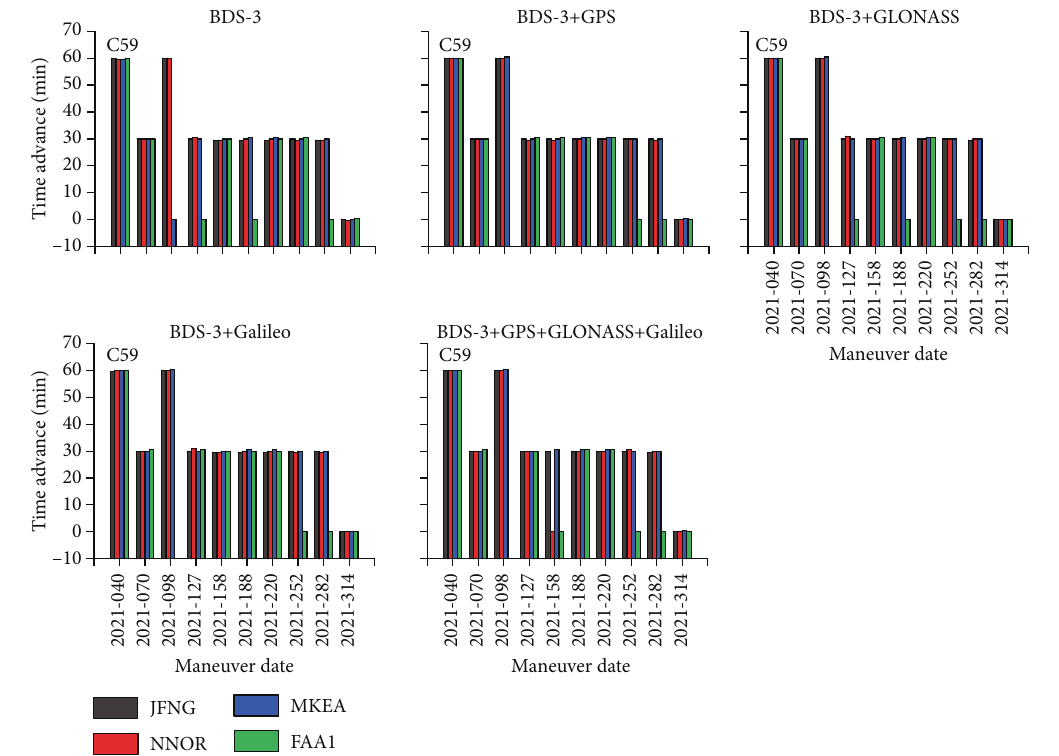
Figure 15: Comparison of detection results for C59 maneuvering start time by di ff erent stations using the same combined system.